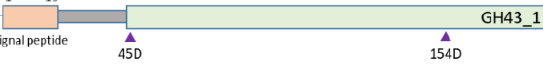
Figure 1. Schematic representation of the domain structure of FcAraf43. A predicted signal peptide in the first 19 amino acids is represented by a pink colored box. The green colored box represents the conserved region characteristic for the CAZy GH43 family 1 ( α -L–arabinofuranosidase enzymes). The purple triangles indicate the locations of residues that constitute the active catalytic site of the